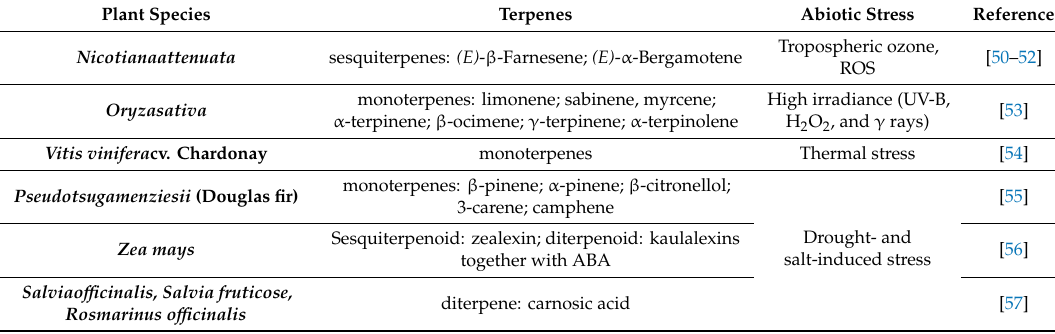
Table 1. Abiotic stress-associated terpenes and